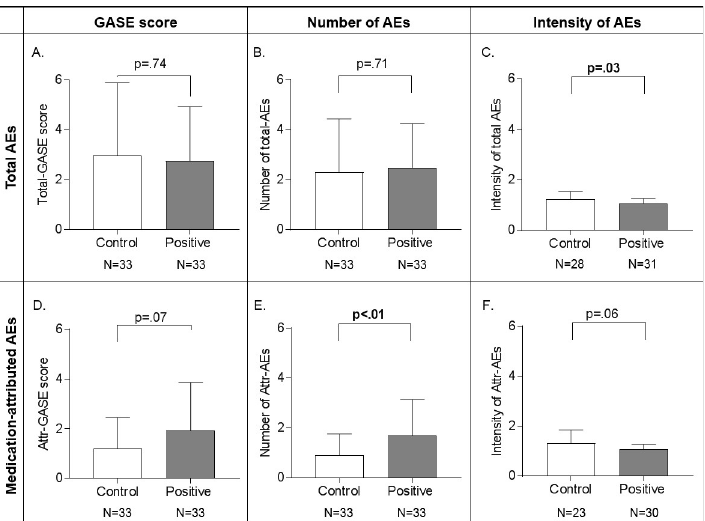
Fig 3. Group comparisons of the Generic Assessment of Side Effects (GASE) score, and its sub-components (number of adverse events (AEs) and intensity) for total and attributed AEs. For total AEs, the GASE score and number of AEs was not significantly different between information groups (A,B), however, the intensity of AEs was stronger in the control group (C). For the attributed AEs, the GASE score difference was not significant (D), the number of AEs attributed to the treatment was higher in the positive group (E). There was no significant between group difference in the mean intensity of attributed AEs (F). Note that the intensity of AEs (E) (and attributed AEs (F)) is only calculated for those who reported AEs (and attributed AEs to the medication (F)), hence the decreased N of participants. Error bars represent mean +/-